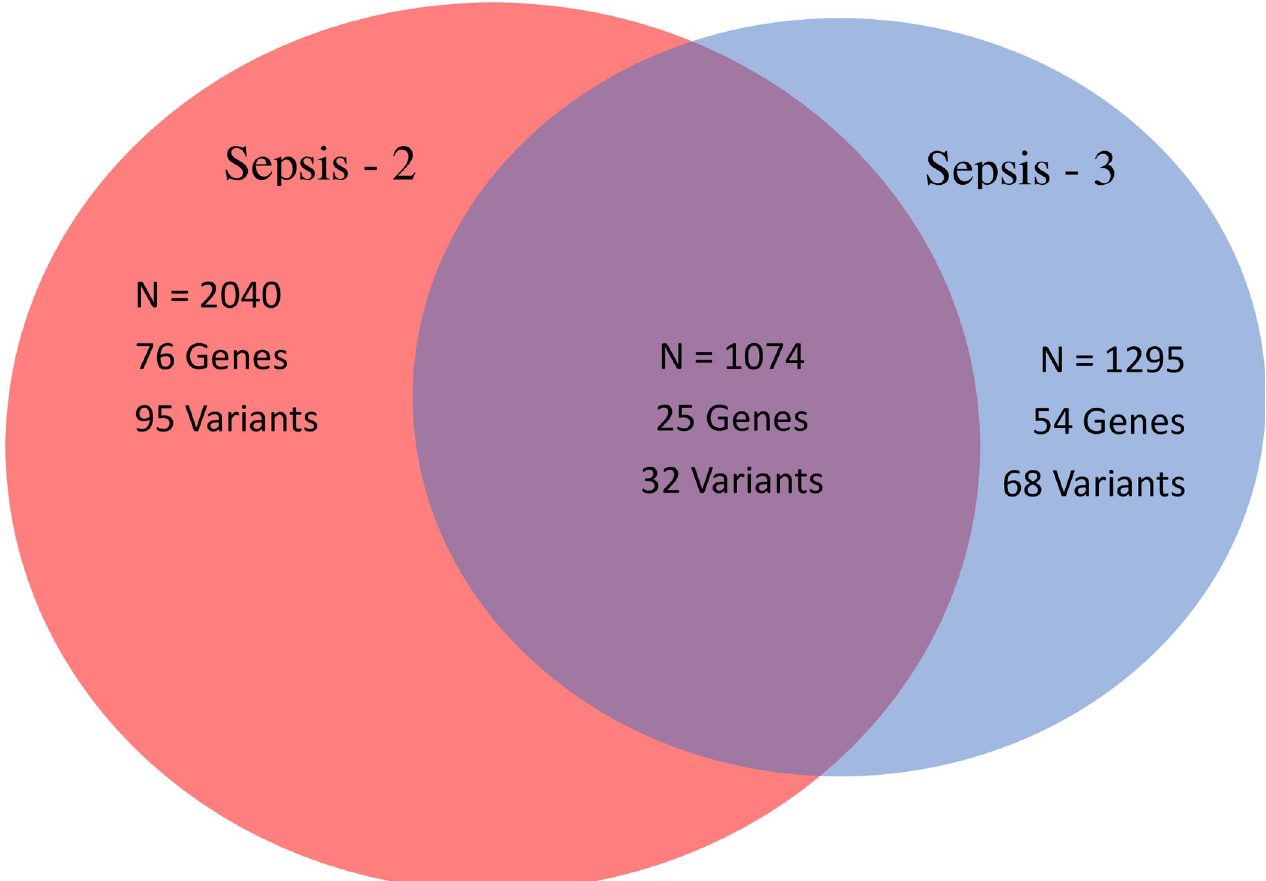
Fig 2. Venn Diagram showing the number of patients with sepsis by Sepsis-2 (N = 2040) or Sepsis-3 (N = 1295) criteria or both (N = 1074) and the numbers of genes and genetic variants associated with each sepsis phenotype.